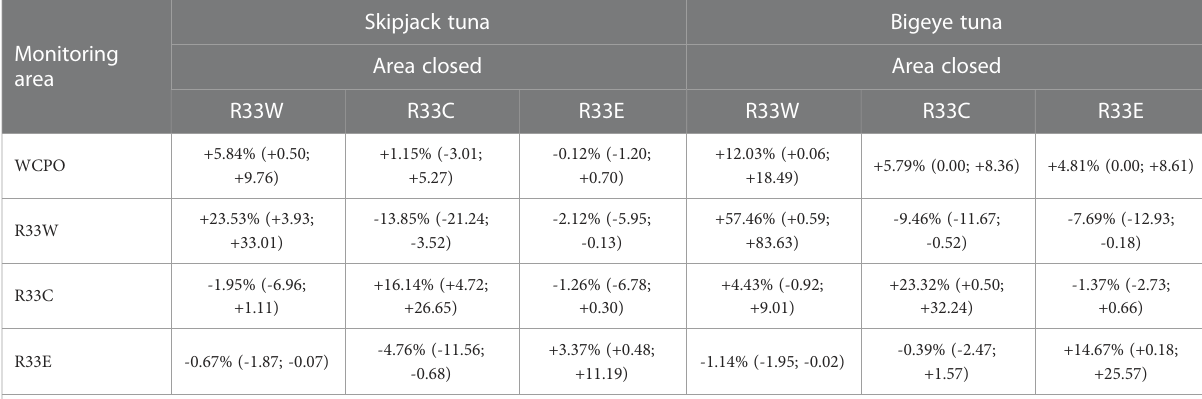
TABLE 2 Average impact 1 (monthly range in parentheses) on skipjack and bigeye tuna spawning biomass ( SB ) of hypothetical large spatial closures corresponding to approximately 33% of the western and central Paci fi c Ocean (WCPO, Paci fi c Ocean west of 150°W) in western (R33W), central (R33C) and eastern (R33E) zones during